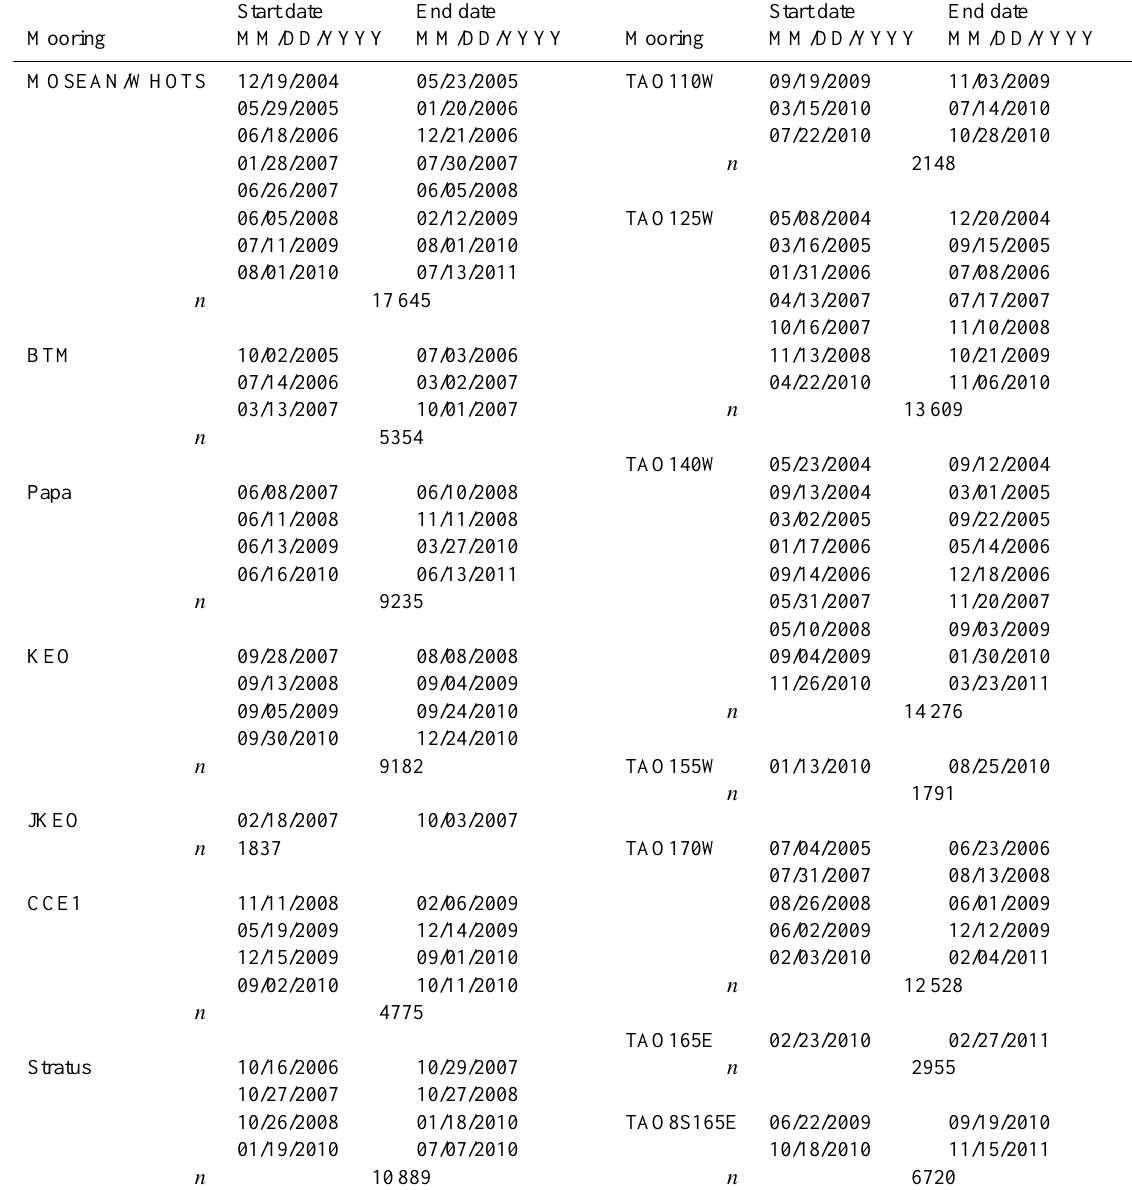
Table 6. List of open-ocean mooring deployments in the open-ocean MAPCO 2 data set. n is the total number of measurements collected at each mooring location during these